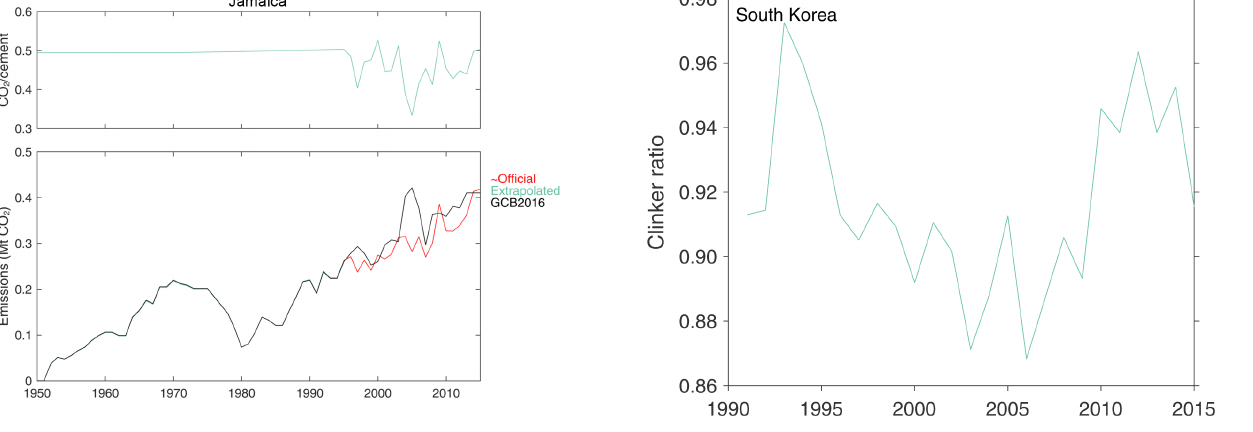
Figure C24. South Korea’s approximate clinker ratio, with no ac- count for clinker trade.